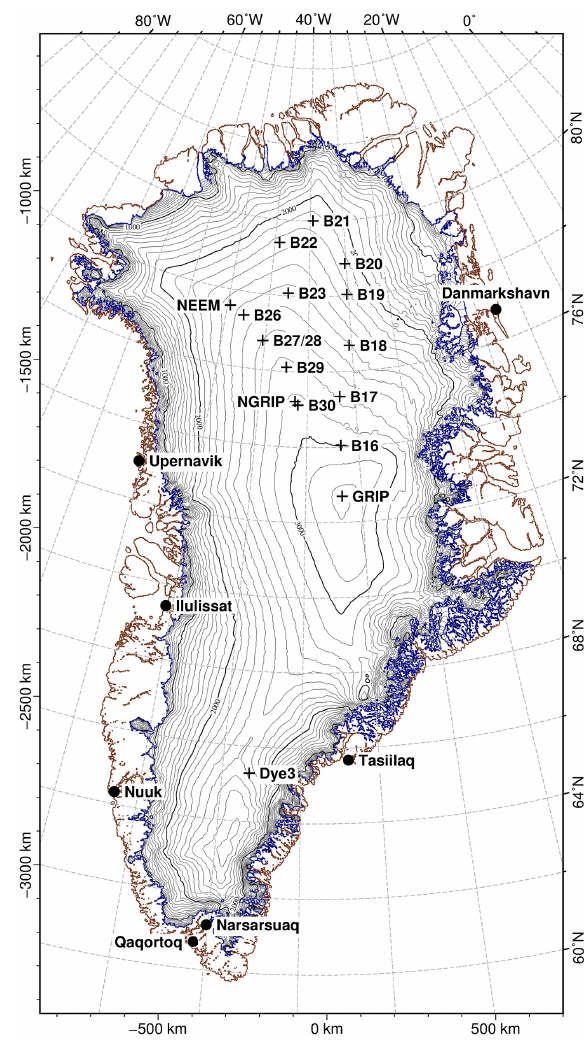
Figure 1. Map of Greenland with NGT ice cores (B16–B23, B26– B30 crosses), deep drilling sites (crosses) and towns (black dots). The ice surface topography is according to Bamber et al. (2013), (mapping: Polar Stereographic (WGS84), Standard Parallel 71, Lat- itude of Projection Origin −